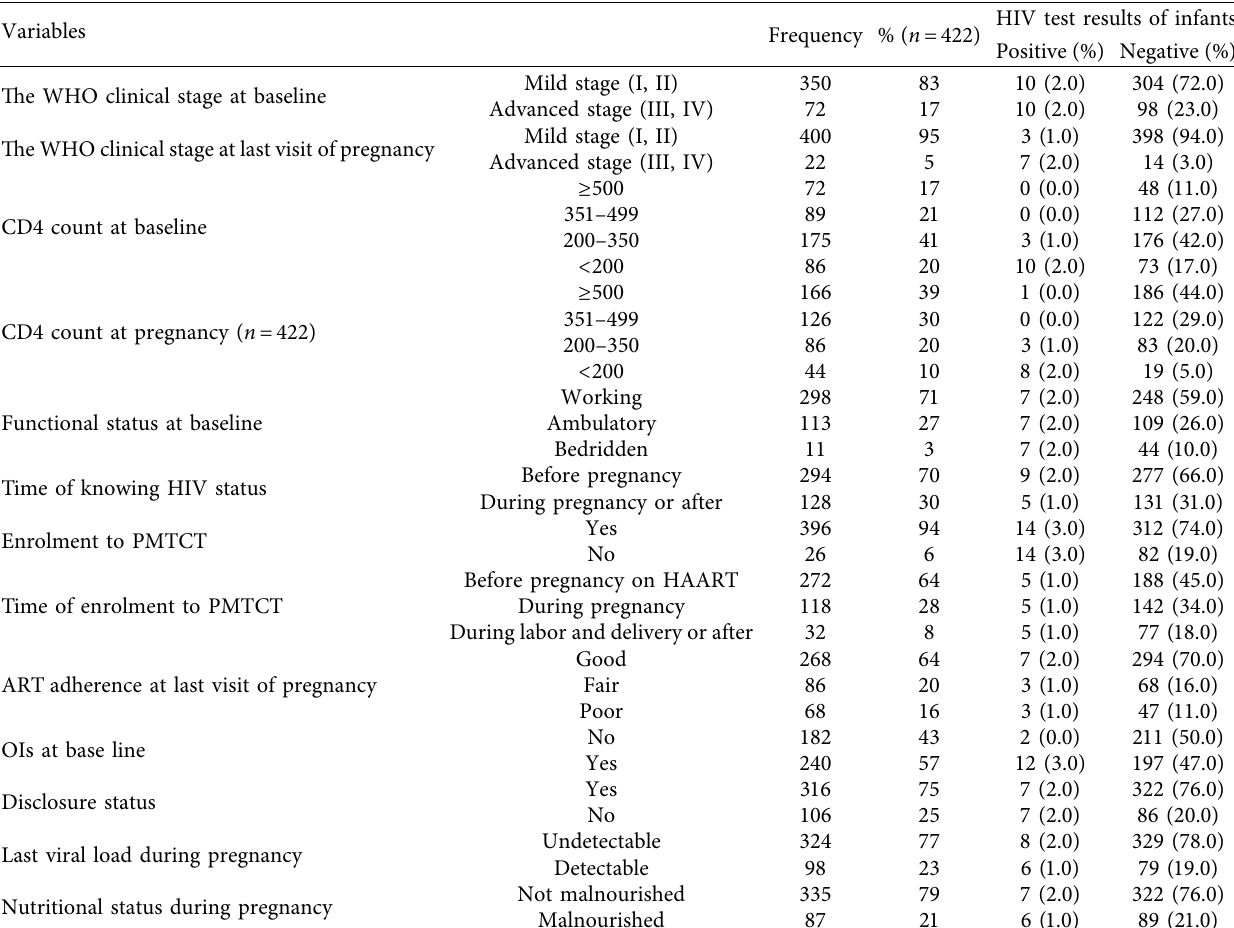
Table 1: Clinical characteristics of mothers of HIV-exposed infants in general hospitals of West Guji Zone, Oromia, Ethiopia, 2020 ( n �